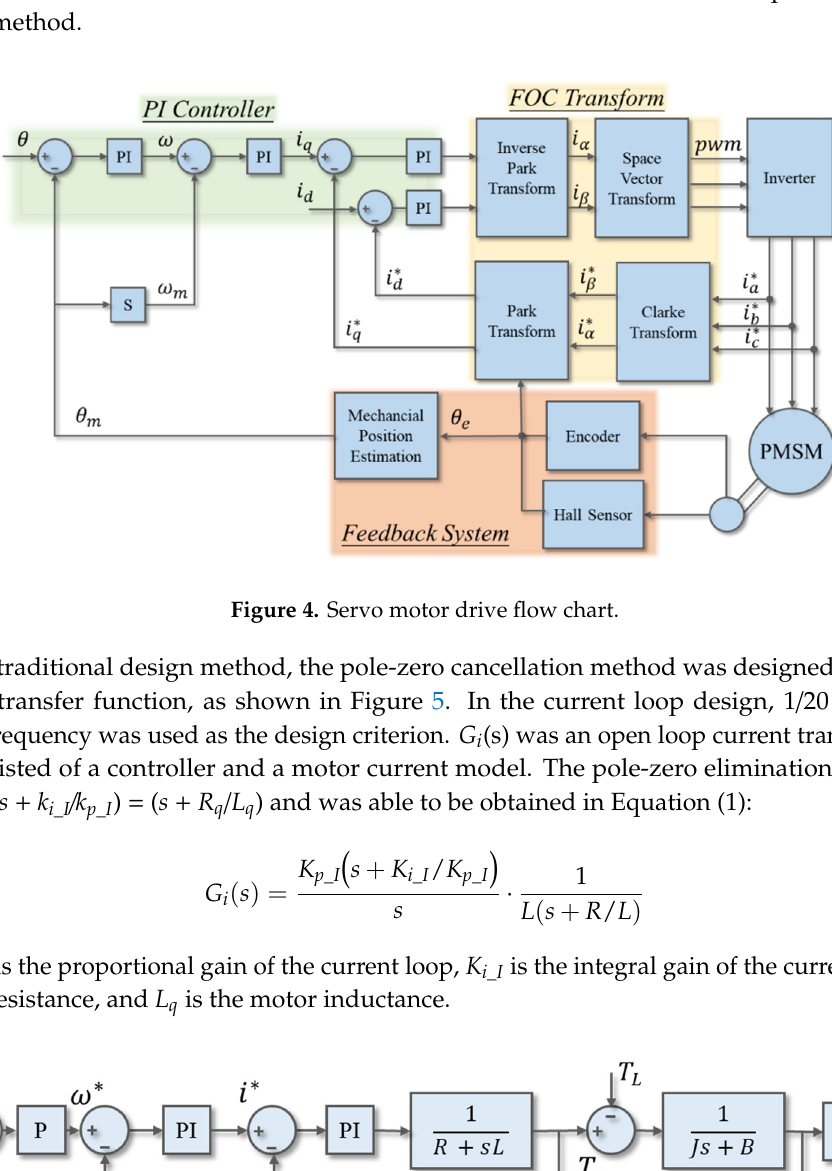
Figure 5. Servo motor control loop.